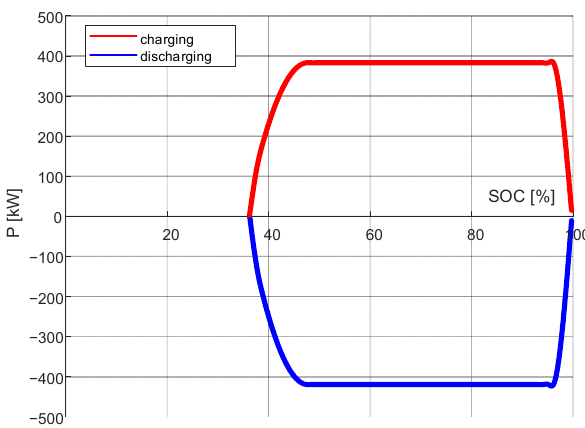
Figure 6. Determined charging and discharging characteristics of the BESS based on 1 min data.